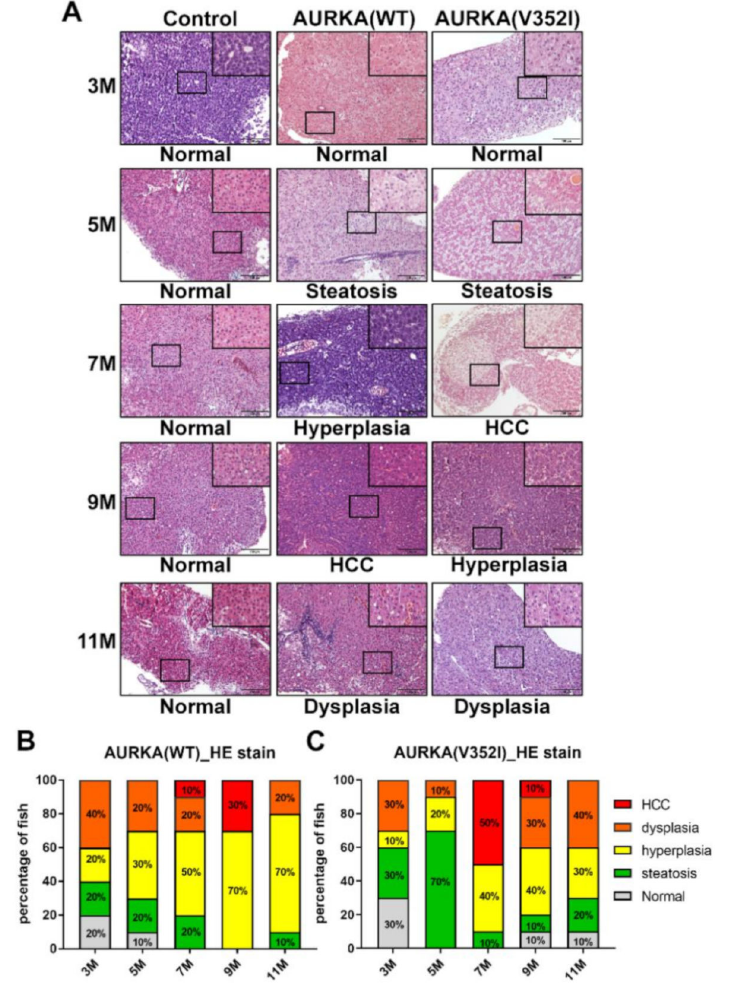
Figure 6. Hematoxylin and Eosin staining reveals that AURKA(V352I) dramatically promotes hepatocellular carcinoma (HCC) at 7 months, and AURKA(WT) promotes HCC at 9 months of age. ( A ) Representative images of HE staining in control, AURKA(WT) and AURKA(V352I) at 3, 5, 7, 9, and 11 months; ( B , C ) Statistical analysis of the AURKA(WT) and AURKA(V352I) HE stain results shown as percentage of fish displayed normal (gray), steatosis (green), hyperplasia (yellow), dysplasia (orange), and HCC (red) at different